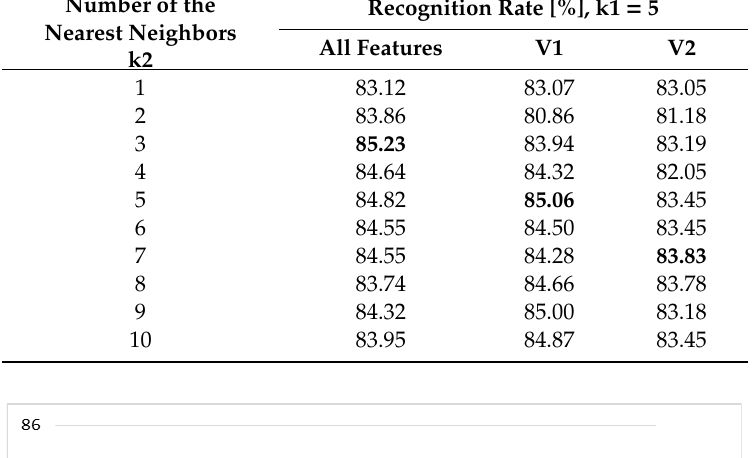
Table 11. Recognition rates for the MSR Action 3D dataset using representatives (ten-fold cross-validation LOSO).